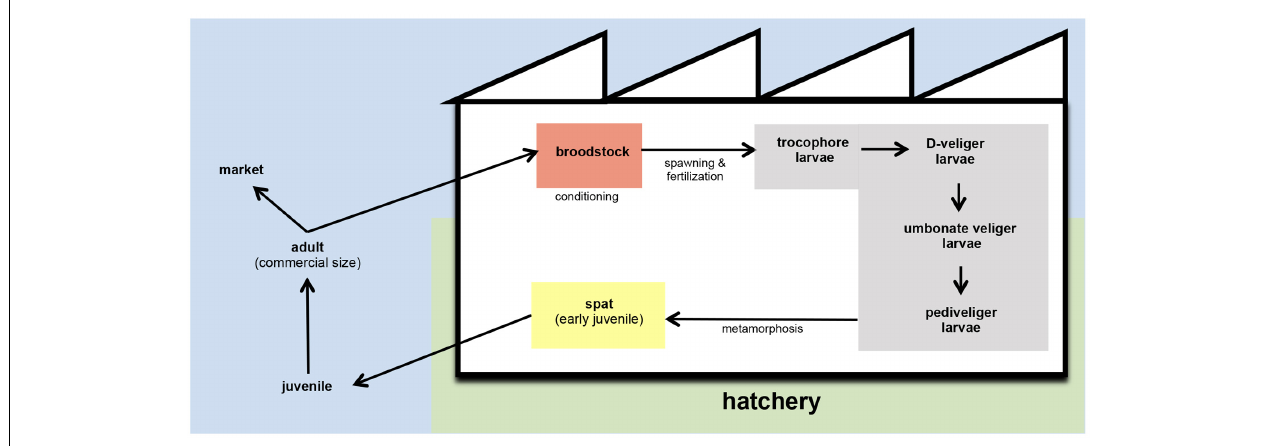
FIGURE 1 | Schematic representation of bivalve husbandry. In hatcheries, broodstock are kept in conditioning tanks (red) until spawning. After fertilization, embryos are transferred to larval tanks (gray) where larvae reach the different stages of development. From settlement and metamorphosis, spat is kept in spat tanks (yellow) and grow until the adequate size to carry on the culture out of the hatchery. In the field, juveniles are fattened with the nutrients content in natural environment until they reach the commercial